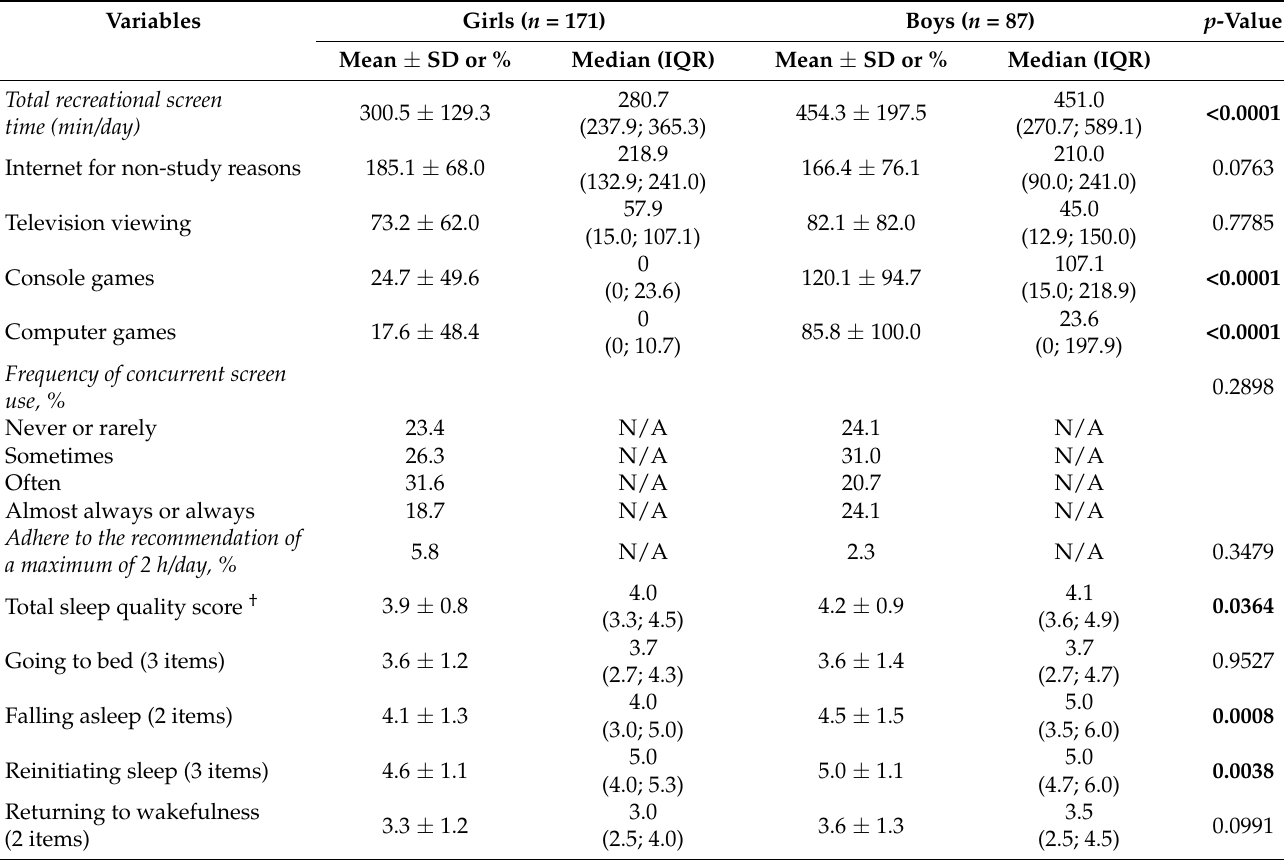
Table 2. Adolescents’ recreational screen time and sleep quality ( n = 258).